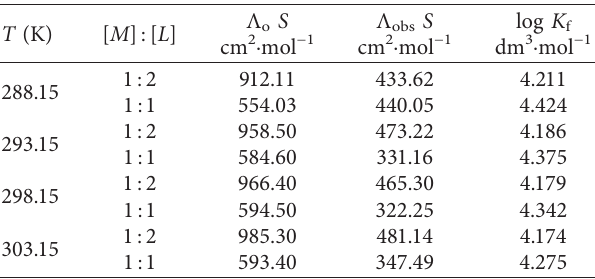
Figure 9: The relation between Λ m and the [M]/[L] molar ratio for (a) bulk Cu-CFT complex and (b) nano-Cu-CFT complex in distillate H 2 O at different temperatures. Table 7: Limiting molar conductance ( Λ Table 8: Limiting molar conductance ( Λ o ) and formation constant ( K f ) for bulk Cu-CFT complex in distillate H 2 O at different ( K f ) for nano-Cu-CFT complex in distillate H 2 O at different temperatures.